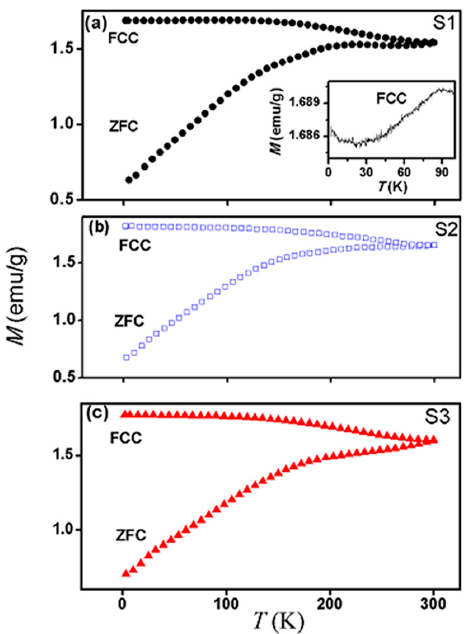
Figure 8. ( a – c ) represents the temperature ‐ dependent magnetization measurements under ZFC and field ‐ cooled cooling (FCC) conditions for all the samples measured at the field of 20 Oe. The inset in ( a ) is the FCC curve below 90 K.